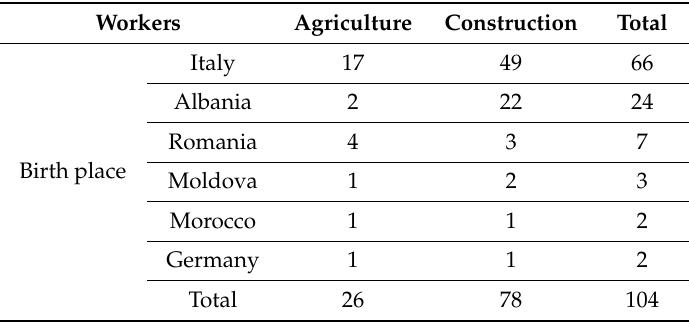
Table 1. Workers by birth place and sector.